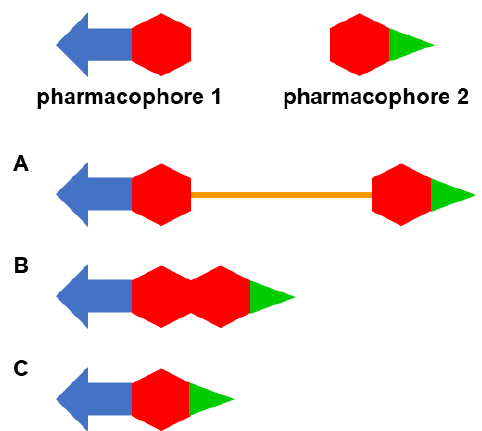
Figure 1. Design strategies used in the framework combination approach: linked hybrid (( A ); the linker is colored in orange), fused hybrid ( B ); merged hybrid ( C ). The elements in different colors represent different structural fragments within each pharmacophore.